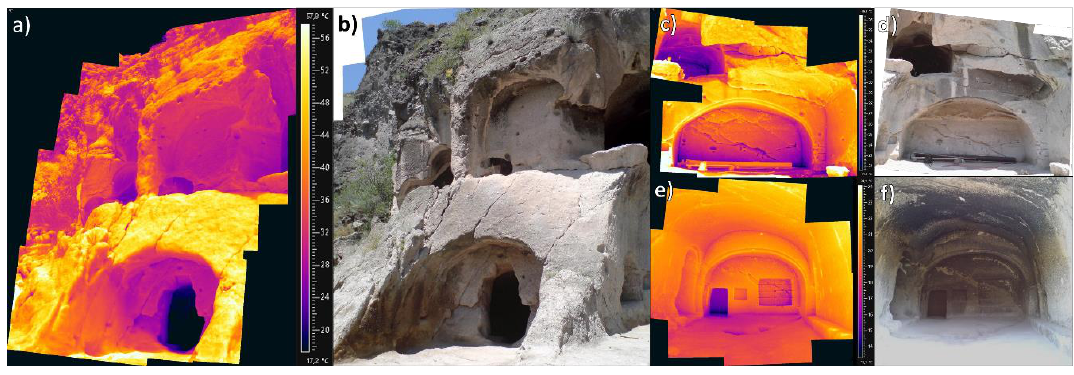
Figure 15. Close-ups of the criticalities in the cave systems acquired on S1: Mosaicked thermogram ( a ) and correspondent photo ( b ) of cave system characterized by persistent and spaced fracture system, mosaicked thermograms of intensively fractured cave system ( c ) with correspondent photo ( d ), mosaicked thermogram of single cave ( e ) and correspondent photo ( f ) characterized by spalling of the rock surface in the roof of the room, controlled by rock weathering and stress degradation.